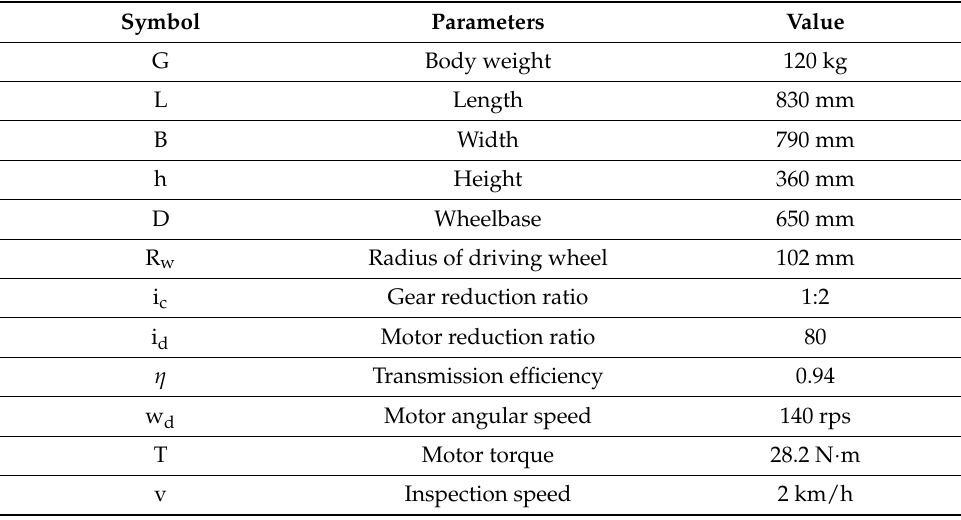
Figure 1. Tracked robot with four swing arms and six tracks. 1. Body; 2. Left track; 3. Left driving wheel; 4. Right track; 5. Right driving wheel. Table 1. Main parameters of tracked